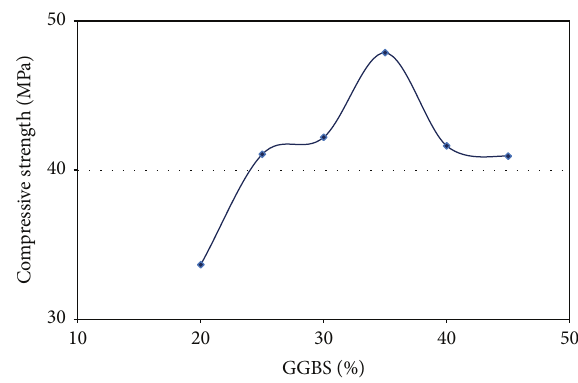
Figure 14: Effect of GGBS on compressive strength mixed with POFA and 20% fixed